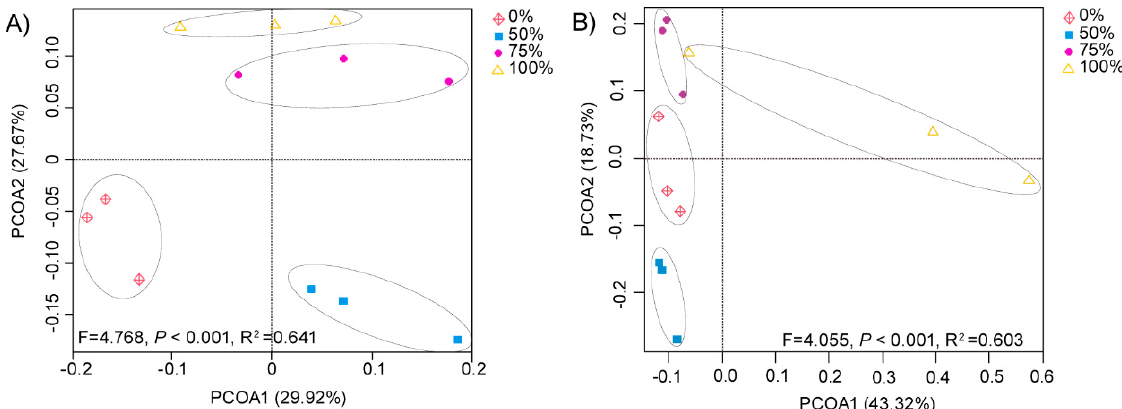
Figure 1. Effect of straw addition on bacterial and fungal beta diversity. Principal coordinate analysis (PCoA) of bacterial ( A ) ( p values < 0.001, R 2 = 0.641) and fungal ( B ) ( p values < 0.001, R 2 = 0.603) communities for fields given 0%, 50%, 75%, and 100% rice straw returning treatments based on the unweighted UniFradistance of bacterial and fungal communities. The first and second principal components of the PCoA of the bacterial community explained 29.92% and 27.67% of the communities, respectively. The first and second principal components of the PCoA of the fungal community explained 43.32% and 18.73% of the communities, respectively. Each treatment had three replicates ( n = 3).